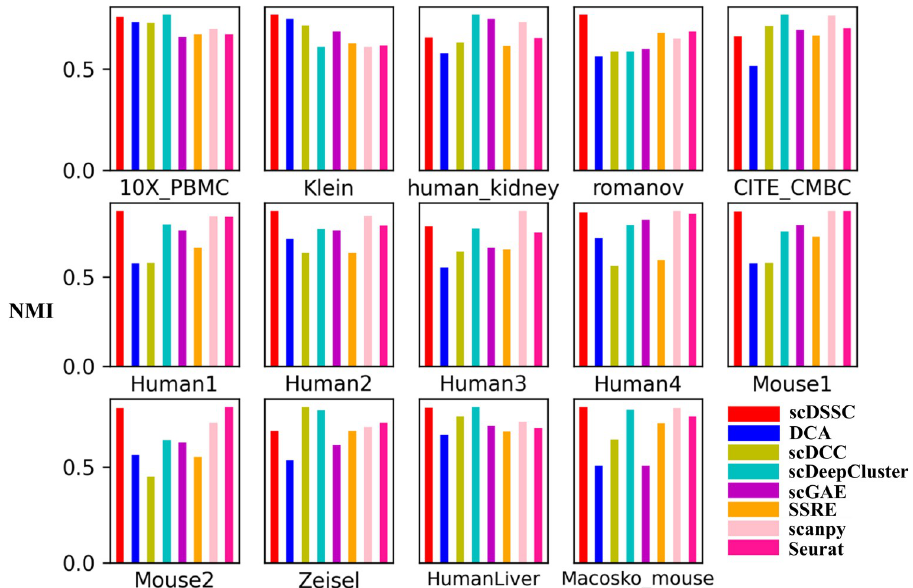
Fig 2. The clustering performance assessed by NMI. Each subgraph represents the clustering results of six clustering methods on a dataset. Different colors correspond to different methods, and the ordinate represents the NMI score.